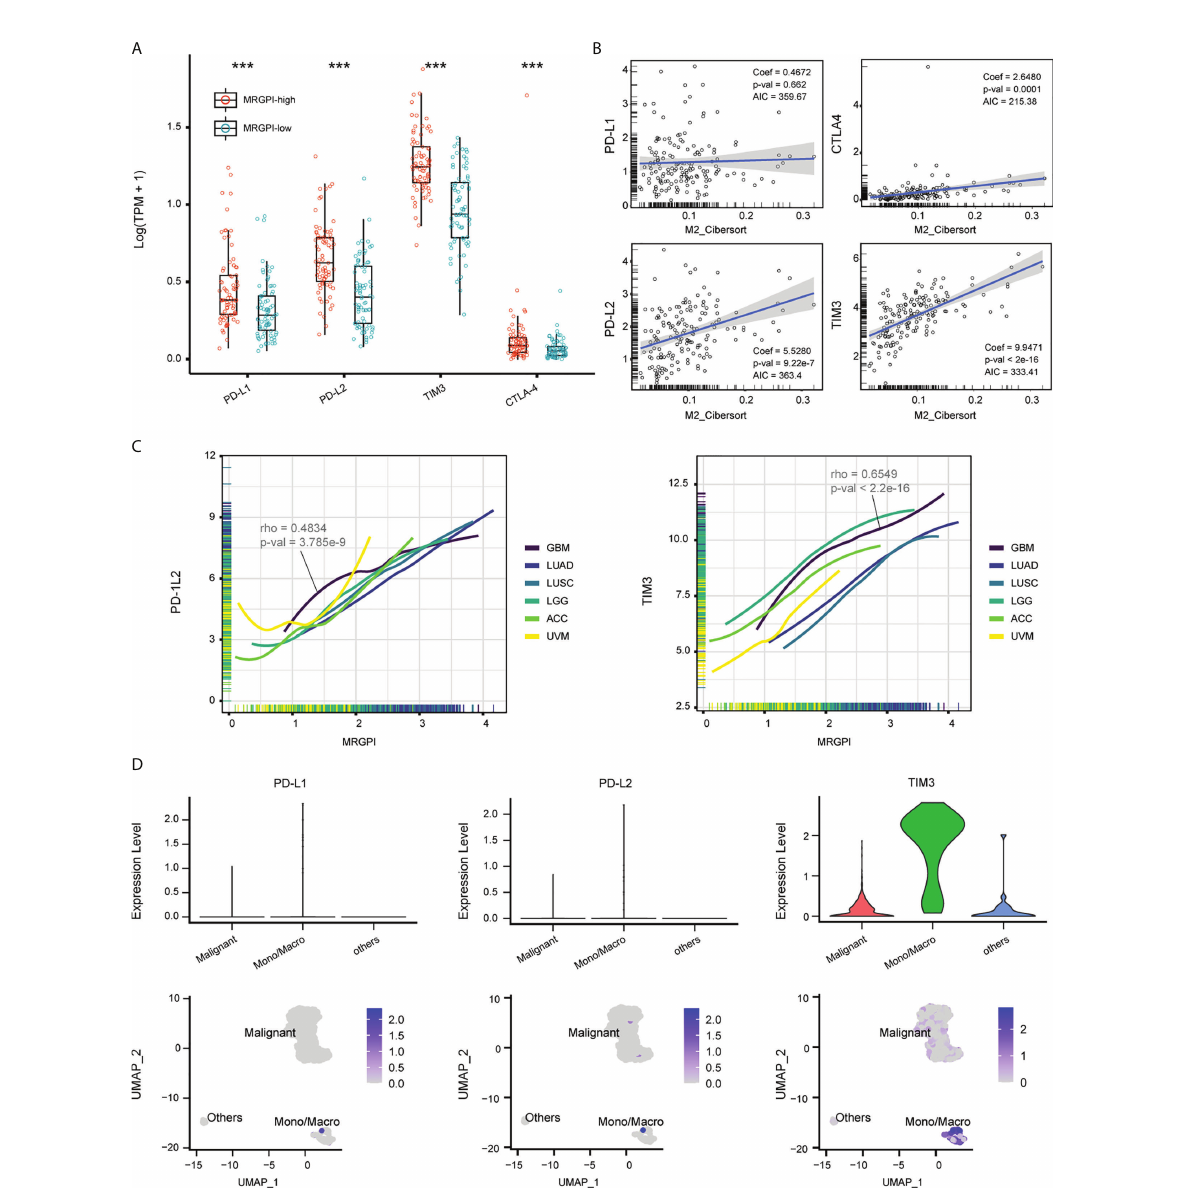
FIGURE 5 Expression of immune checkpoints associated with MRGPI. (A) The expression of PD-L1/2, TIM3, and CTLA-4 based on the TCGA cohort. (B) Multivariate regression analysis estimating the association between the expression of immune checkpoints and M2 macrophage faction. (C) Association between MRGPI and expression of PD-L2 and TIM3 on a pan-cancer scale. ACC and UVM that had sterile lymphocyte in fi ltration and LUAD and LUSC that had abundant lymphocyte in fi ltration were used as references. ACC, Adrenocortical carcinoma; UVM, Uveal Melanoma; LUAD, Lung adenocarcinoma; LUSC, Lung squamous cell carcinoma. (D) The expression of PD-L1/2 and TIM3 at a single-cell resolution based on